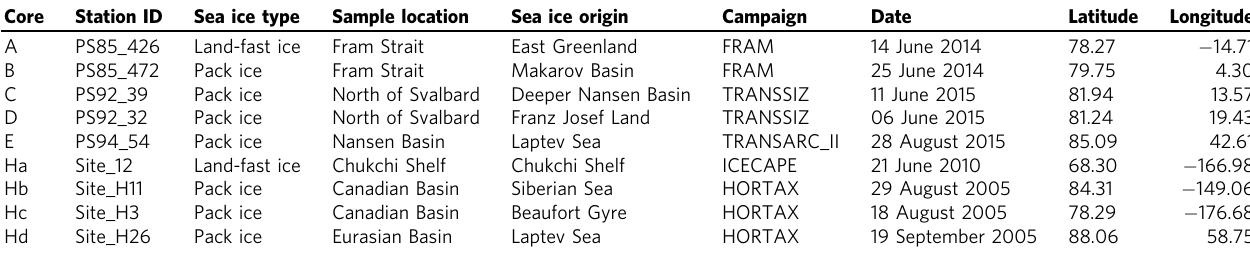
Table 1 Sea ice core sampling and accompanying information table Core Station ID